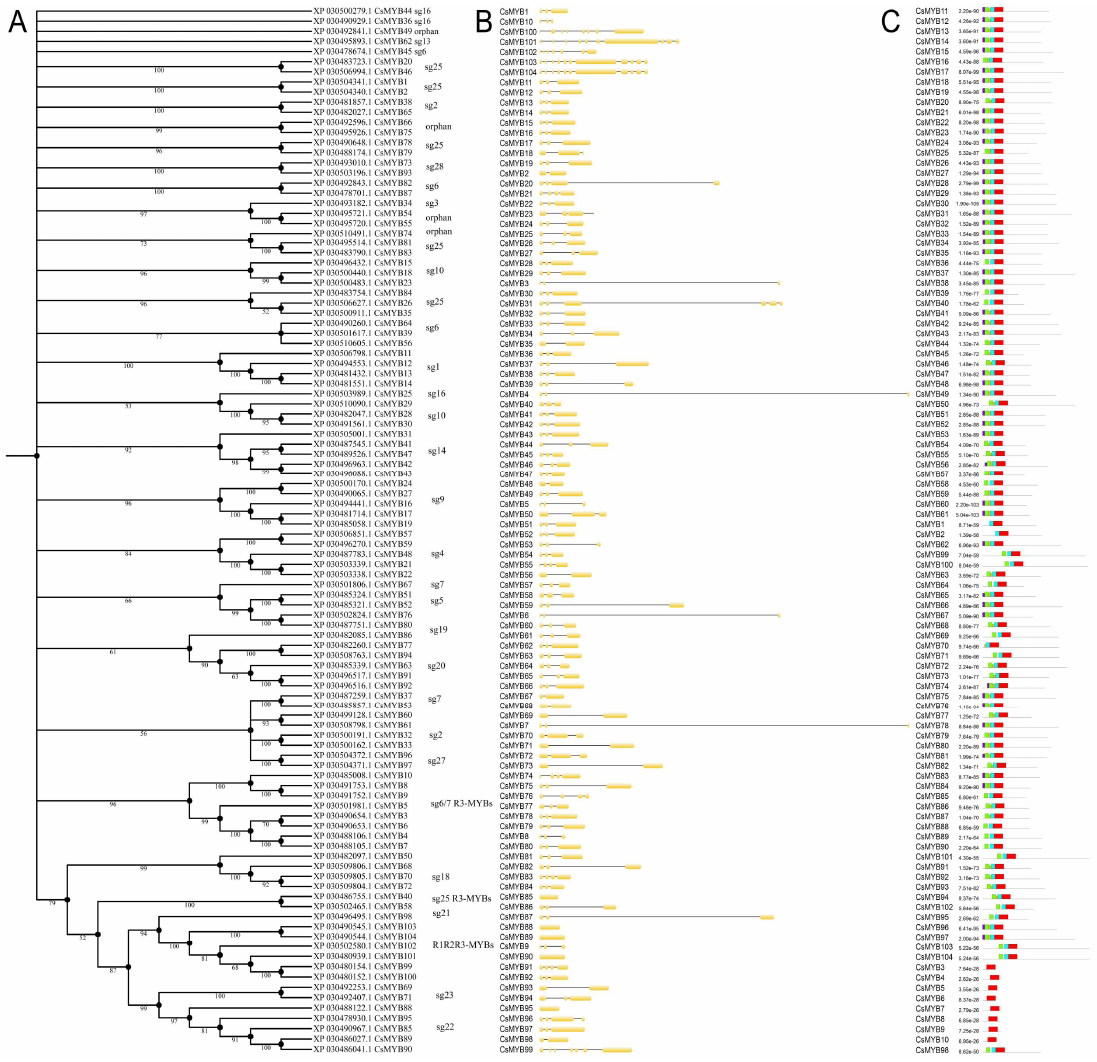
Figure 5. Phylogenetic analysis, gene structure, and motif distribution of Cannabis MYBs. ( A ) Phylogenetic analysis of CsMYBs. The amino acid sequences of the 104 CsMYBs were used to construct the NJ tree using MEGA X with 1000 bootstrap replicates. Bootstrap values > 50 are shown on the branches. ( B ) The locations and lengths of exons and introns of Cannabis MYB family genes. The exons and introns are presented as filled yellow sticks and thin gray single lines, respectively. ( C ) Motifs of CsMYBs were analyzed using MEME suite. Five kinds of colored blocks correspond to five di ff erent motifs in MYB proteins. The length of gray line indicates the length of a sequence with respect to the total dataset, while the position of each block denotes the locations of a motif within a target sequence. Details of motifs’ consensus sequences are listed in Supplementary File